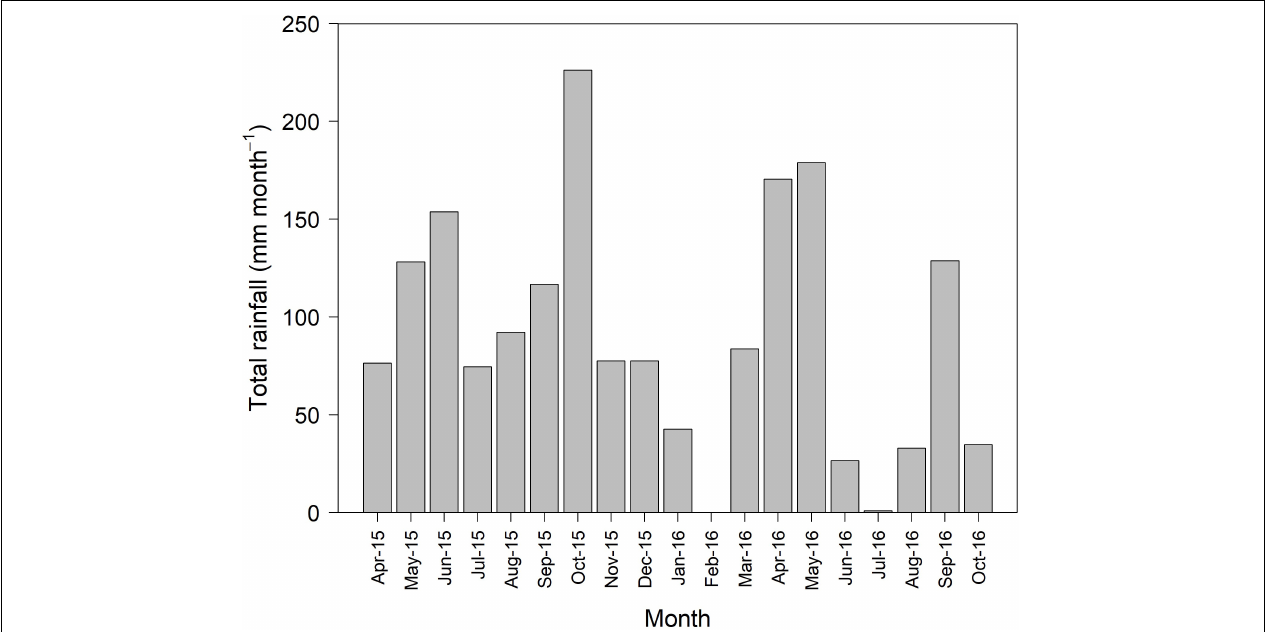
FIGURE 3 | Total monthly rainfall at the weather station in Mbale, Uganda, during the study period April 2015–October 2016. No or very little rainfall occurred in the area in February and July 2016. Data source: Directorate of Water Resources Management,